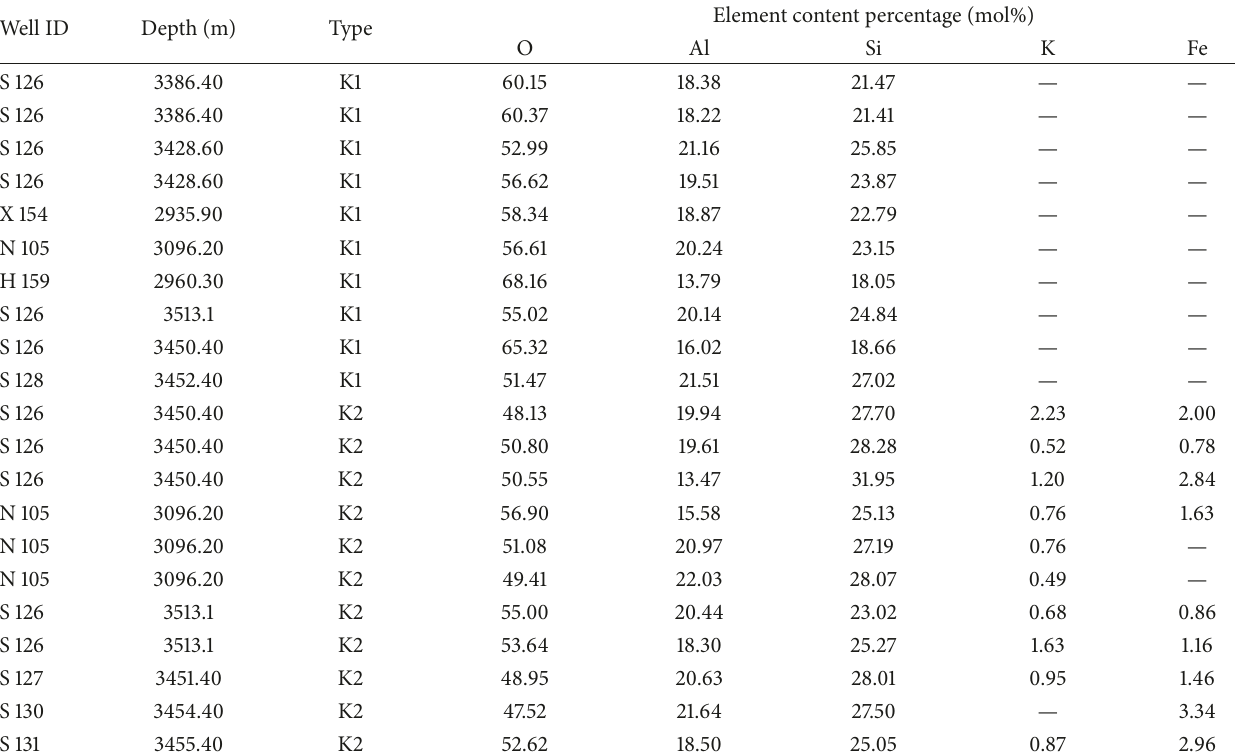
Table 2: Element component characteristics of authigenic kaolinites in Es of Dongying